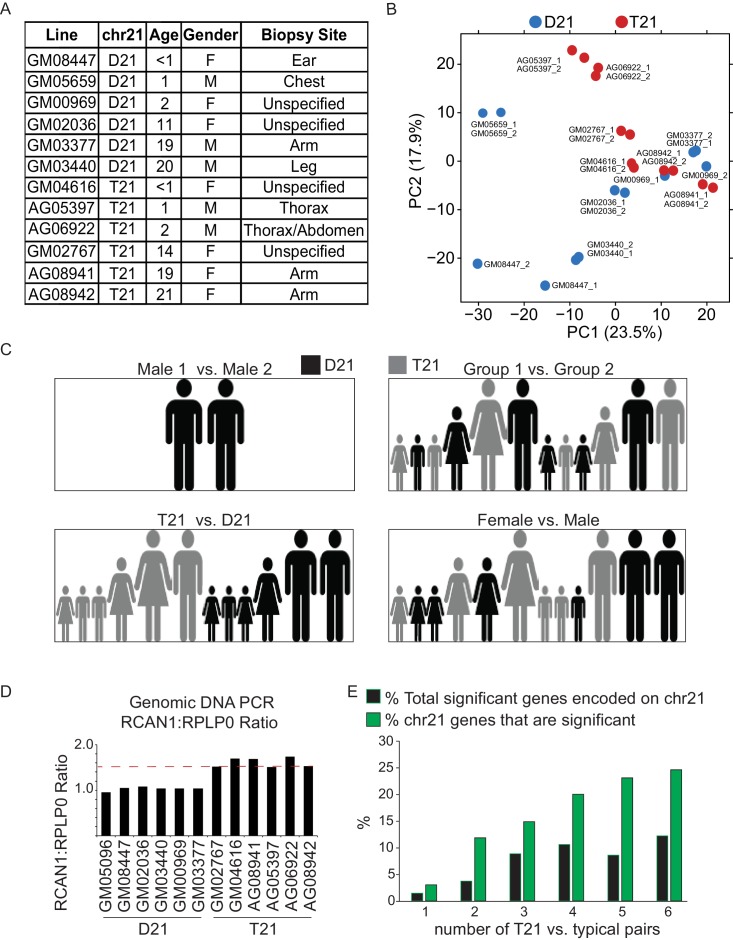
T21 and D21 fibroblast RNA-seq.(A) Description of fibroblast cell lines used in this study. (B) Principal component analysis (PCA) of fibroblast RNA-seq samples demonstrates tight grouping of biological replicates. (C) Schematic of group comparisons. (D) PCR of genomic DNA for the RCAN1 gene encoded on chr21 confirms T21 status. RPLP0 is a control gene encoded on chr12. (E) Bar graph displaying how numbers of differentially expressed genes (DEGs) encoded on chr21 increase with sample size.